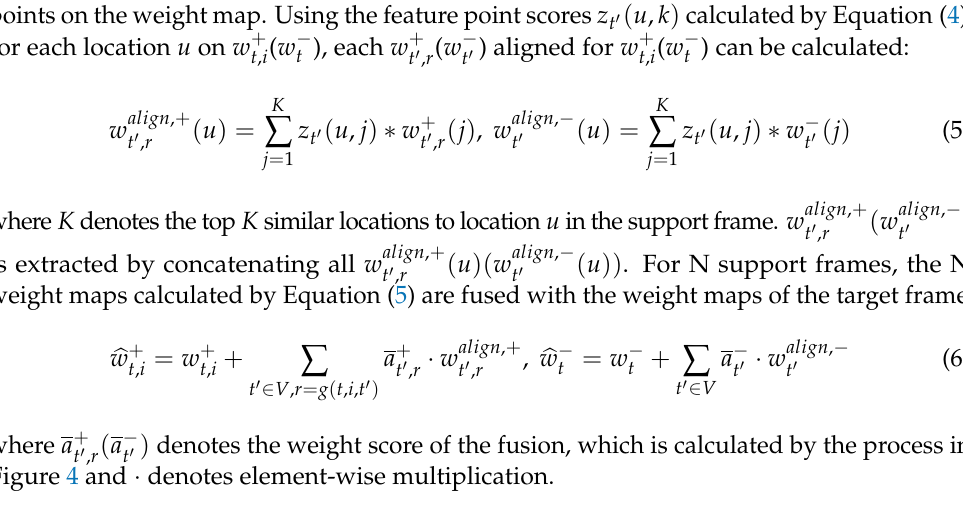
(cid:9) (cid:8) ) ∈ R H × W and a + ( a − a − ( ). a + t (cid:48) t (cid:48) t (cid:48) , r t (cid:48) ∈ V